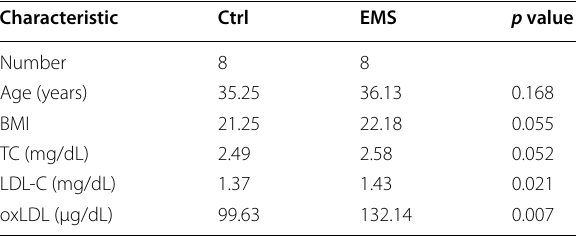
Table 1 Clinical characteristics of the plasma samples